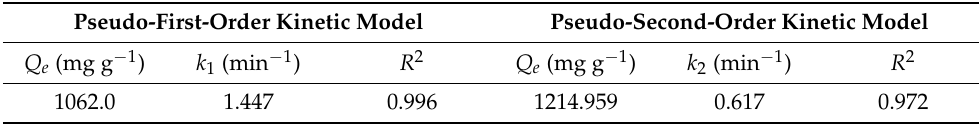
Table 1. The relevant kinetic parameters of lysozyme adsorption on the NHMs. Pseudo-First-Order Kinetic